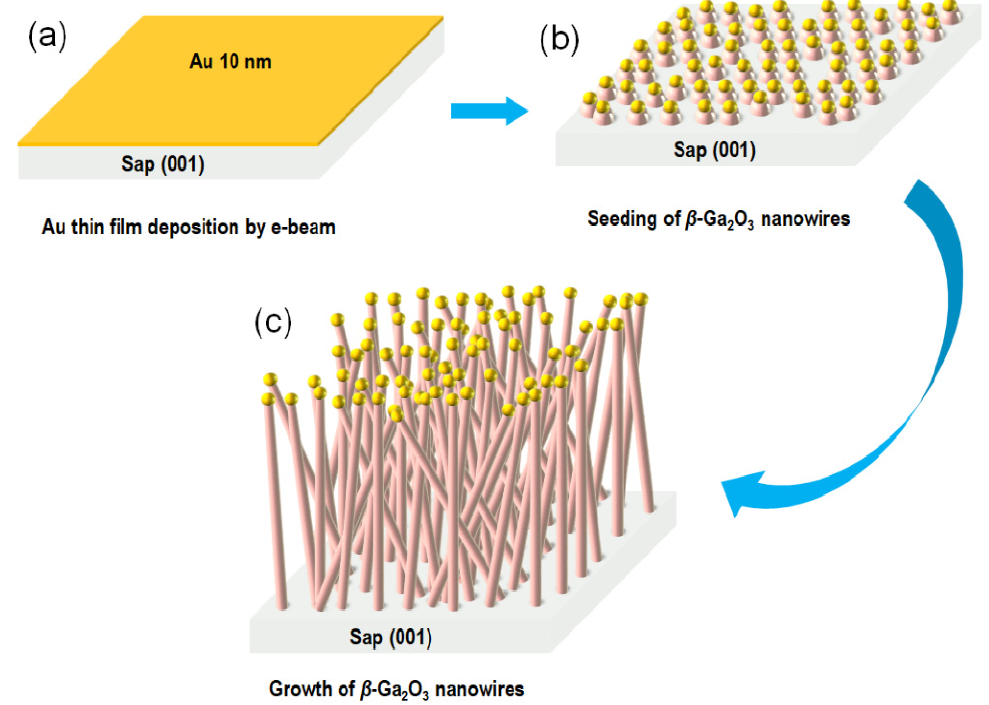
Figure 1. Schematic diagram depicting growth process of single-crystal β -Ga 2 O 3 nanowires on c -plane sapphire substrates by metalorganic chemical vapor deposition (MOCVD). (a) Au thin-film deposition. (b) Seeding of β -Ga 2 O 3 nanowires. (c) Growth of β -Ga 2 O 3 nanowires.